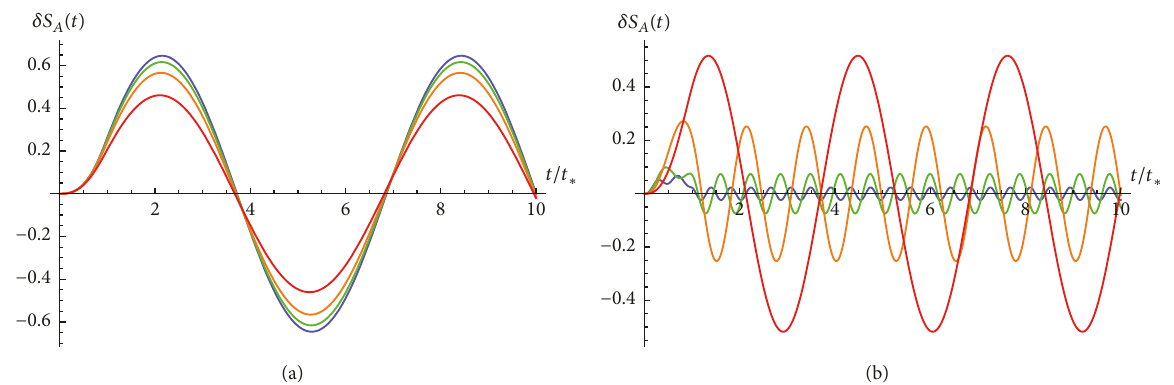
Figure 12: Entanglement entropy after a Floquet quench as a function of (a) dimension and (b) frequency. The colors blue, green, orange, and red denote 𝑑 = {5,4, 3,2} in part (a) and Ω = {15,10, 5, 2} in part (b), respectively. We have set 𝜃 = 0.1 , 𝑧 = 1.5 .